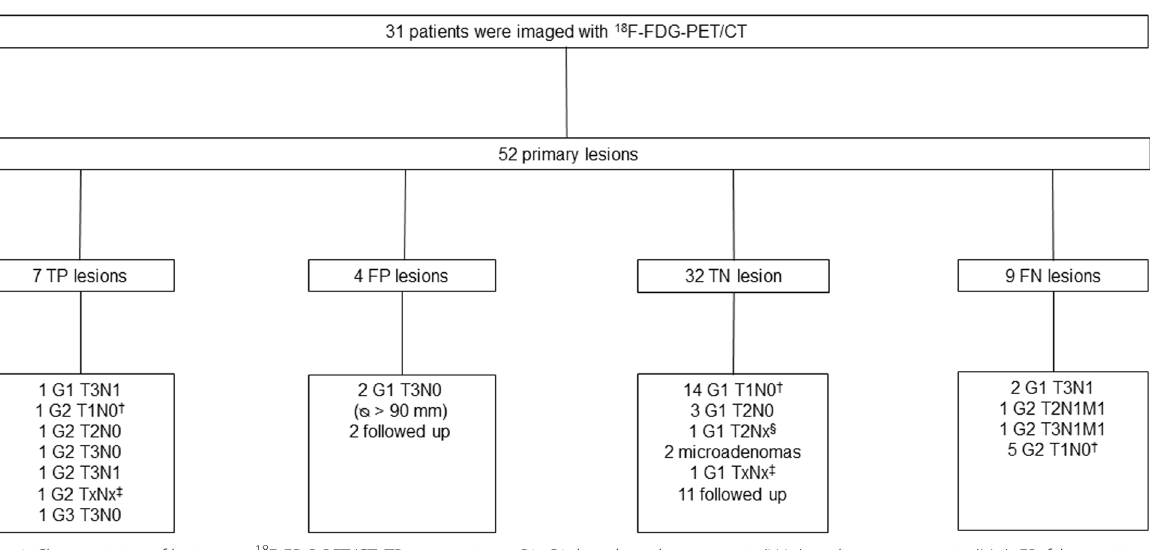
Fig. 2 Characteristics of lesions on 18 F-FDG-PET/CT. TP, true-positive, G2, G3, lymph node metastasis (LN+) or distant metastasis (M+); FP, false-positive, G1, no lymph node metastases (LN-) or no distant metastases (M-); TN, true-negative, : G1, LN- or M- ; FN, false negative, G2, G3, LN+ or M+. † MEN1 patient underwent total pancreatectomy: on histopathological report total of 13 tumors was detected: (8 = G1, 5 = G2); 1 was 18 F-FDG-positive (1 TP), and other 12 18 F-FDG-negative (8 TN and 4 FN). ‡ Diagnosis was made by biopsy, stage unknown. § Unknown LN status due to